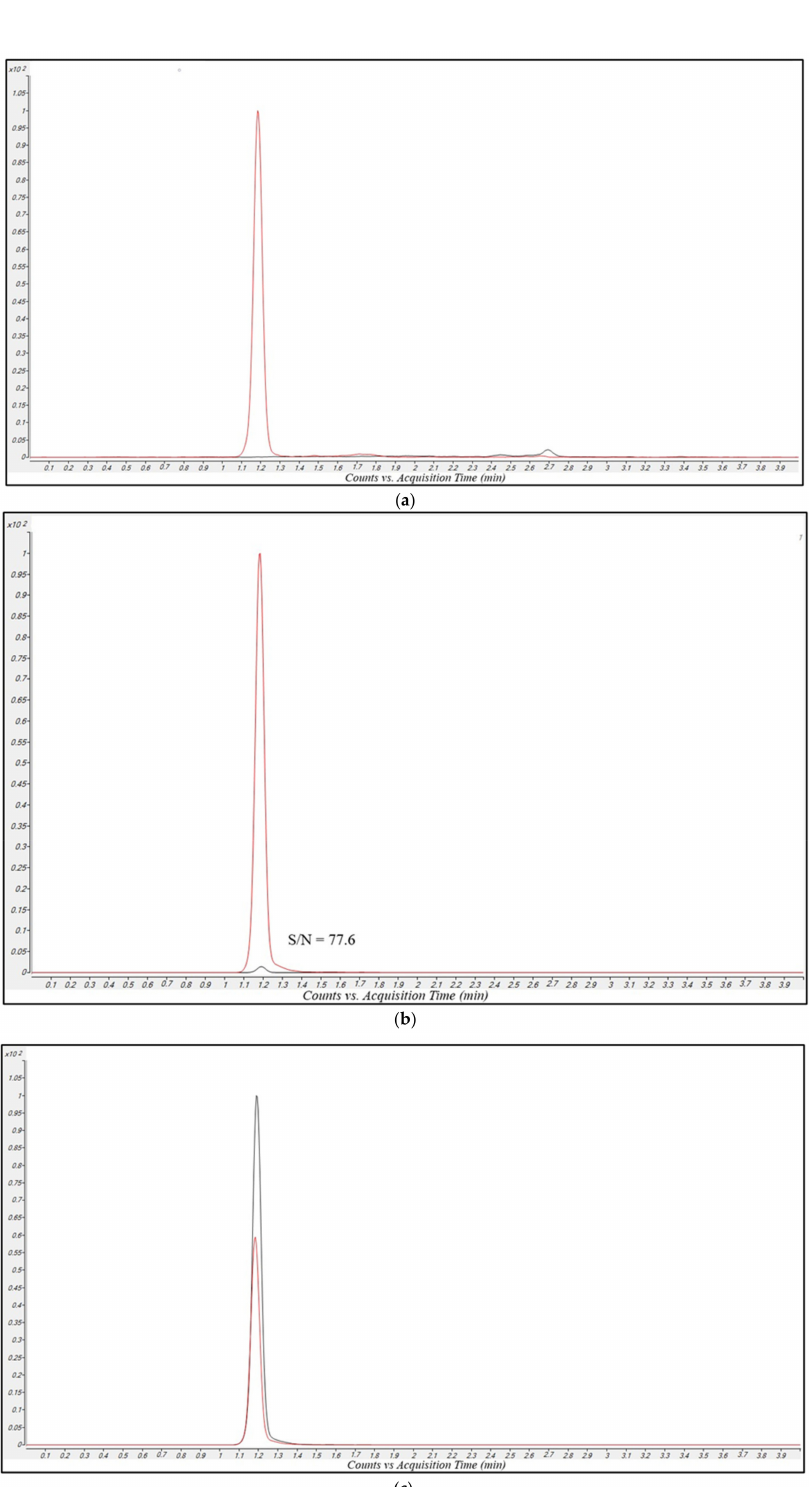
Figure 1. Overlayed MRM chromatograms for MRP (black line) and MRP-d6 (red line) obtained in the analysis of ( a ), a blank sample extracted with the methanol-IS solution, showing the absence of peaks related to MRP and the presence of a well-defined peak for MRP-d6; ( b ) an LLOQ sample with printed S/N ratio (SNR); ( c ) a real patient sample showing good peak shape and resolution of specific